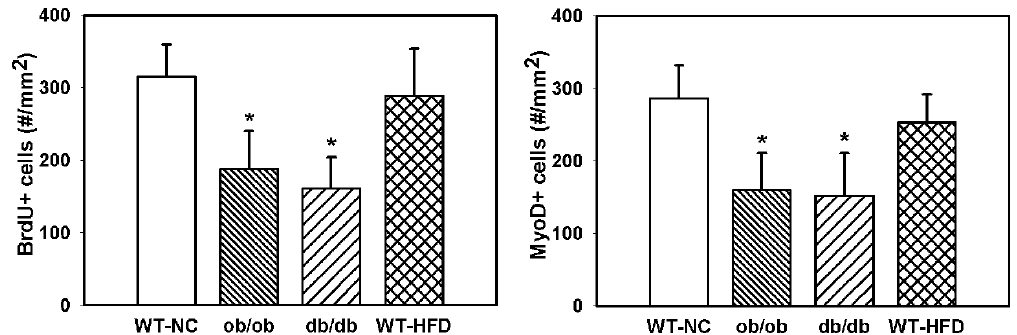
FIGURE 2. Cell proliferation and myoblast accumulation following muscle injury is impaired in ob/ob and db/db mice. Injured muscles collected from WT mice fed NC, ob/ob mice, db/db mice, and WT mice fed HFD. Left: summary data for BrdU incorporation into newly synthesized DNA on day 5 postinjury, expressed as the number of nuclei staining positive for BrdU/mm 2 muscle area. Right: summary data for number of nuclei staining positive for MyoD on day 5 postinjury, expressed per mm 2 muscle area. Bars are means ± standard error, n = 4–6 per time point. *= Mean value significantly smaller than that for WT-NC mice; p <